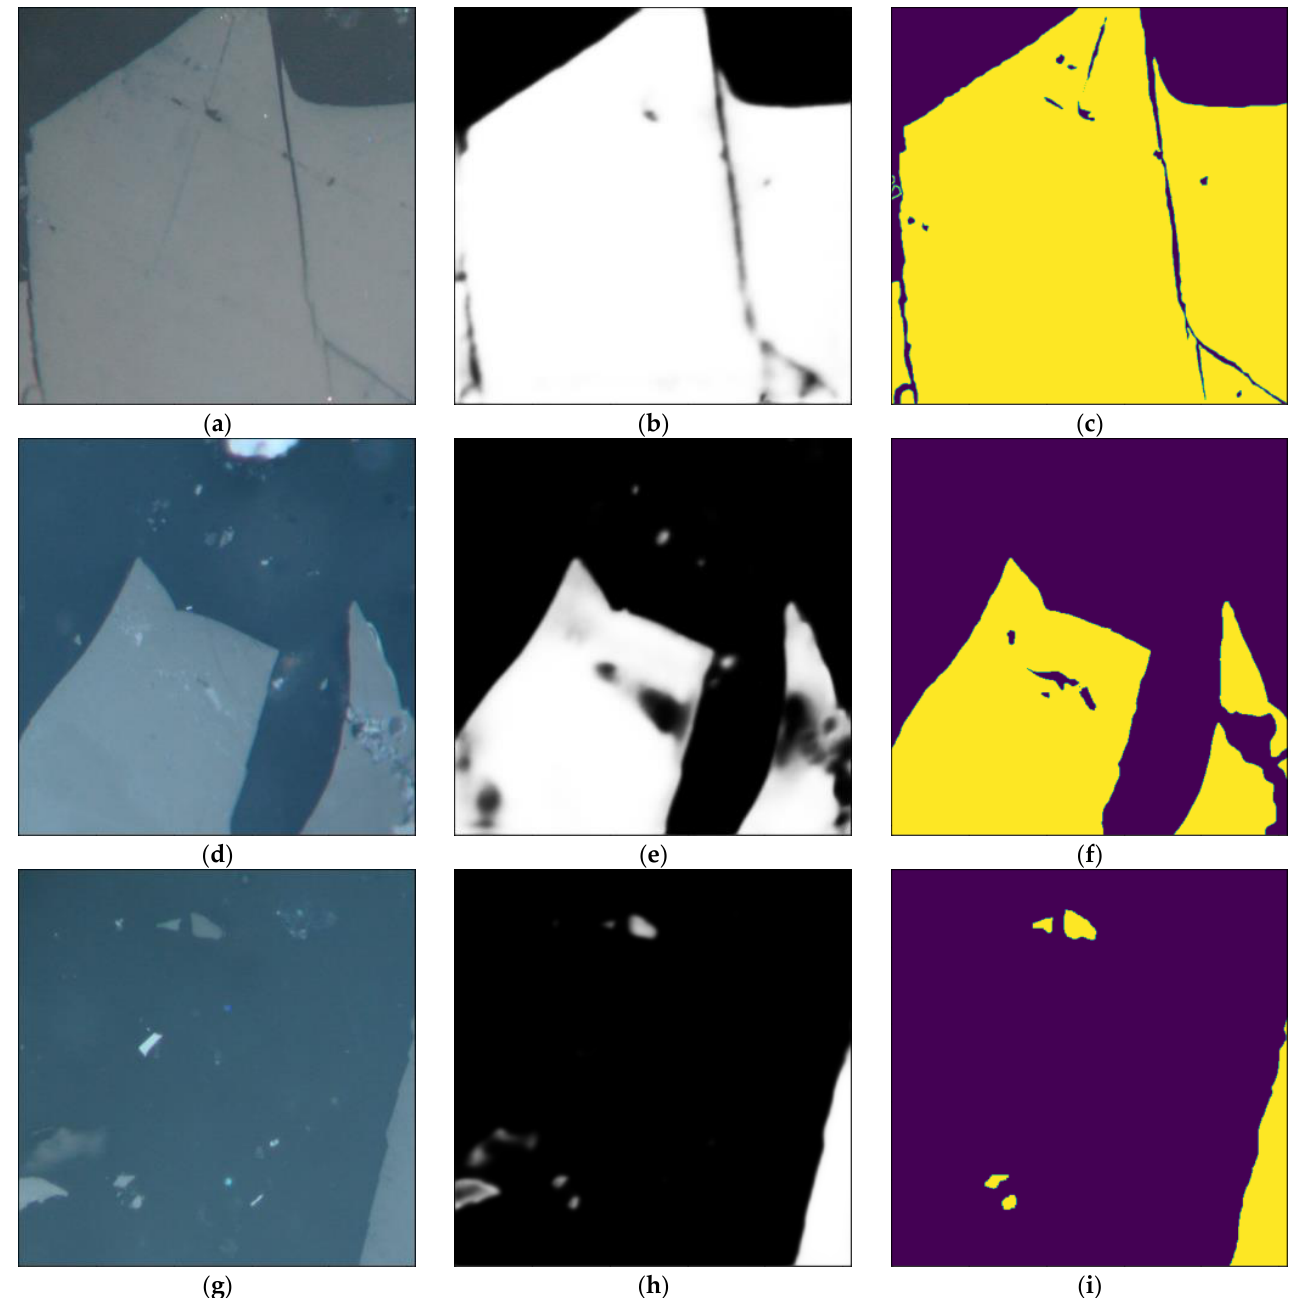
Figure 7. The results of vitrinite segmentation. ( a ), ( d ), ( g ) Input images; ( b ), ( e ), ( h ) segmentation results; ( c ), ( f ), ( i ) ground